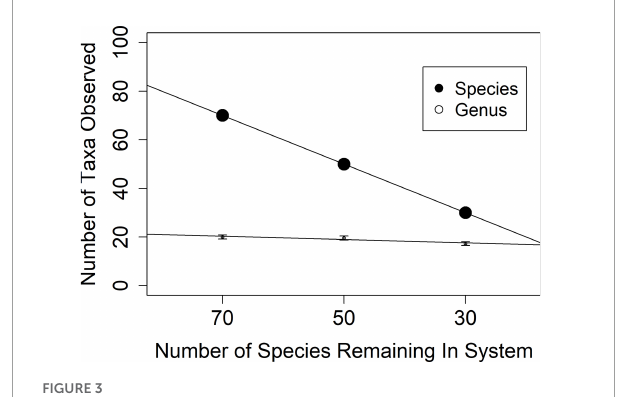
FIGURE3 Genus and species richness in 10 simulated scenarios of increasing species loss from a hypothetical assemblage of 100 species in 20 genera. When species loss rates are equivalent across genera, genus level metrics fail to show taxonomic loss.